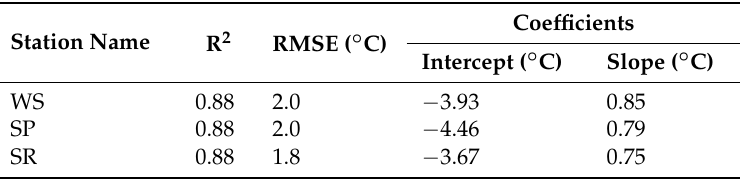
Table 3. The bias, RMSE, and R 2 between MERRA air temperatures and dew point temperatures from in situ measurements ( p -value <